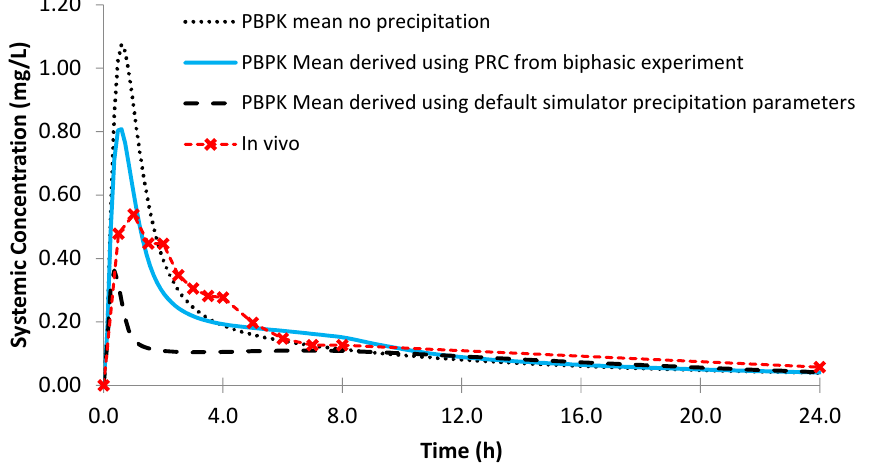
Figure 12. Simulated plasma profile vs. in vivo plasma profile (dashed line with crosses) of itraconazole solution after a single oral dose of itraconazole 200 mg, based on the design of the clinical study by Brouwers et al. [24]. The in vivo plasma profile is represented by the red dashed line with crosses. The simulated plasma profile derived from the biphasic dissolution data, the PBPK default simulator parameters and the profile without precipitation are represented by the solid blue line, the dashed black line and dotted dark blue line, respectively.